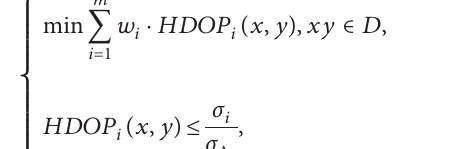
Figure 3: Graph of G h change with tag height.